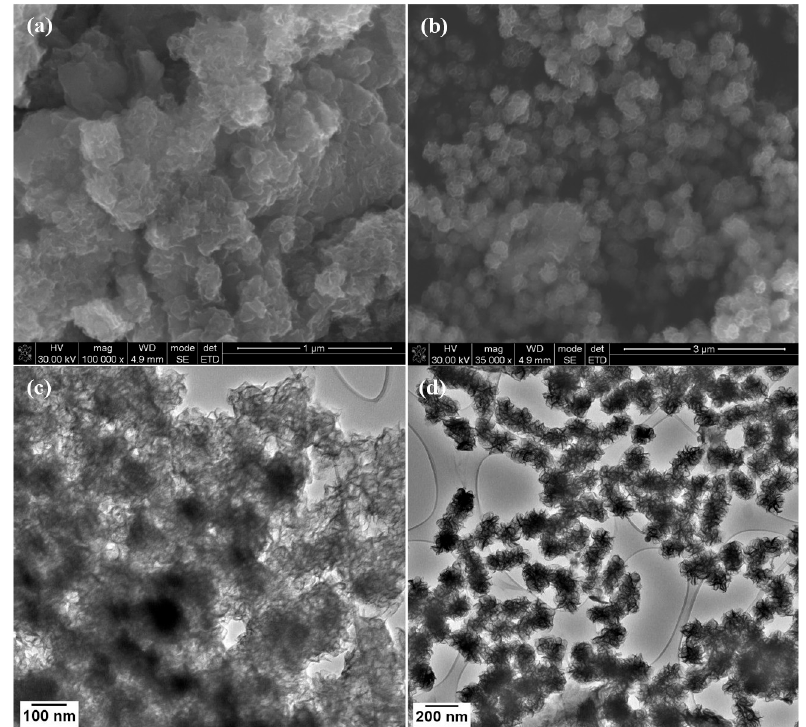
Figure 3. SEM images of ( a ) MoSe 2 nanosheets and ( b ) MoSe 2 nanoflowers and TEM images of ( c ) MoSe 2 nanosheets and ( d ) MoSe 2 nanoflowers.